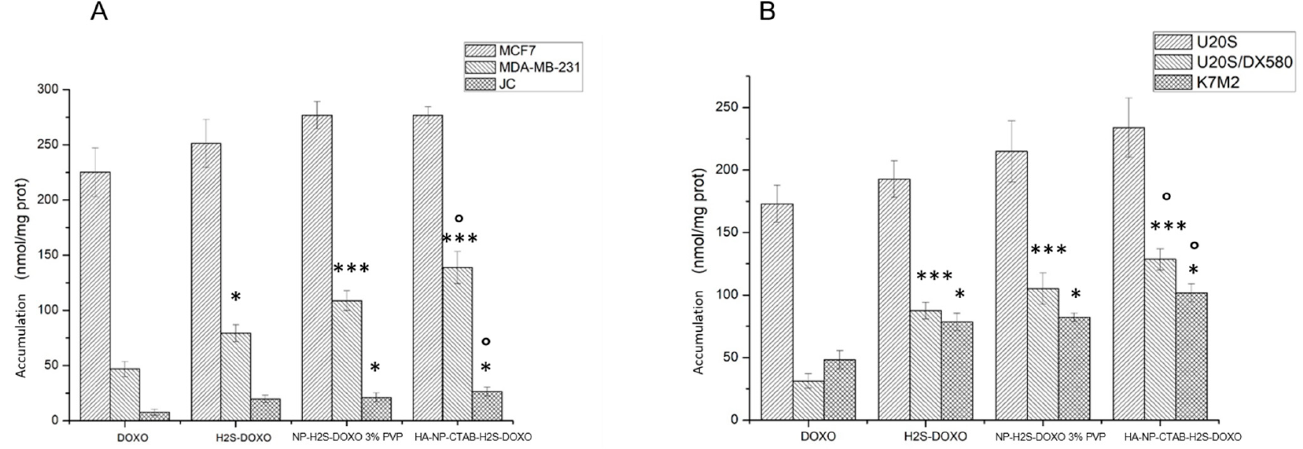
Figure 8 . Intracellular DOXO accumulation in: ( A ). breast cancer cells; ( B ). osteosarcoma cells. Cells were incubated 6 h with 5 µ M with free DOXO, free H 2 S-DOXO, NP-H 2 S-DOXO 3% PVP, and HA-NP-CTAB-H 2 S-DOXO (containing 5 µ M H 2 S-DOXO), then the intracellular accumulation of the drug was measured fluorimetrically (n = 3). Data are means + SD. * p < 0.05, *** p < 0.001: versus DOXO; ° p < 0.05: versus H 2 S-DOXO .